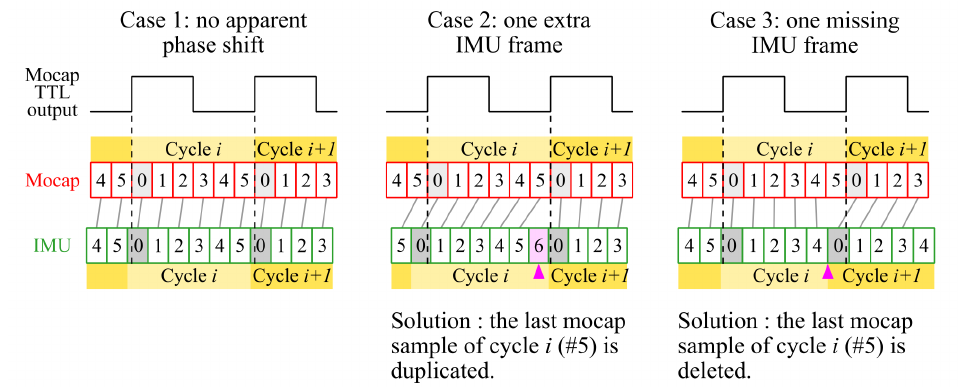
Figure A1. Strategy used to deal with phase shifts between motion capture and IMU acquisition clocks. A TTL output was emitted for one out of six video frames (mocap frame 0, light gray). The rising front of this TTL signal was detected by the IMU acquisition board and used to timestamp the corresponding IMU sample (IMU frame 0, dark gray). Small clock irregularities could result in a jump one IMU sample forward or backward of the timestamp (purple arrowhead in cases 2 and 3, observed for 0.07% of the synchronization cycles). These cases were dealt with by duplicating or deleting the last mocap sample of the corresponding synchronization